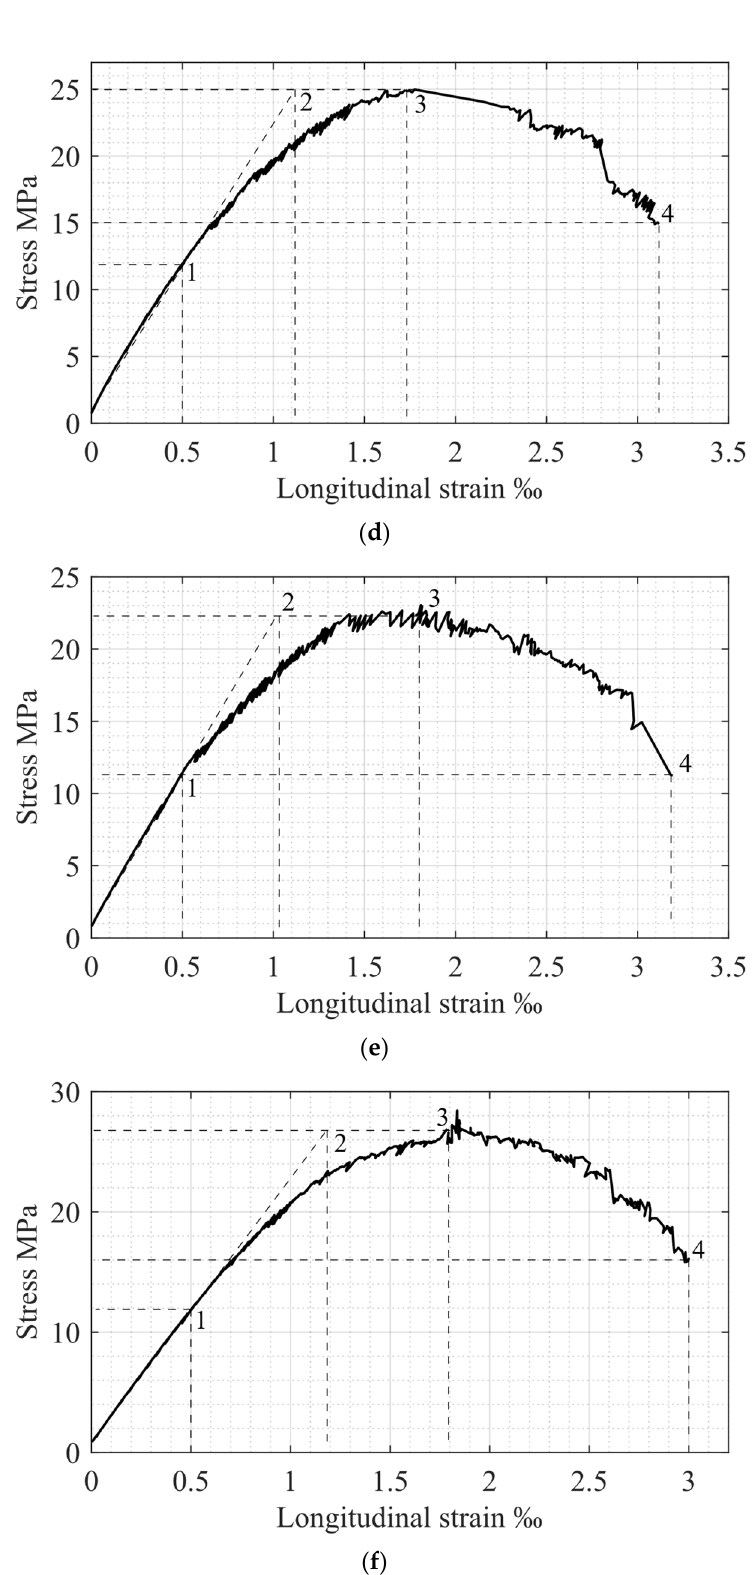
Figure 3. Experimental relationships σ c − ε c : ( a ) Specimen Sp1.1; ( b ) Specimen Sp1.2; ( c ) Specimen Sp1.3; ( d ) Specimen Sp2.1; ( e ) Specimen Sp2.2; ( f ) Specimen Sp2.3. The post-peak concrete behavior area is characterized by the descending branch of the σ c − ε c diagram between points 3 and 4 in Figure 1. It is determined by stresses σ c ul = 0.5 f ck and strains ε c ul ≈ 3.5‰. Experimental results for these parameters are shown in Table